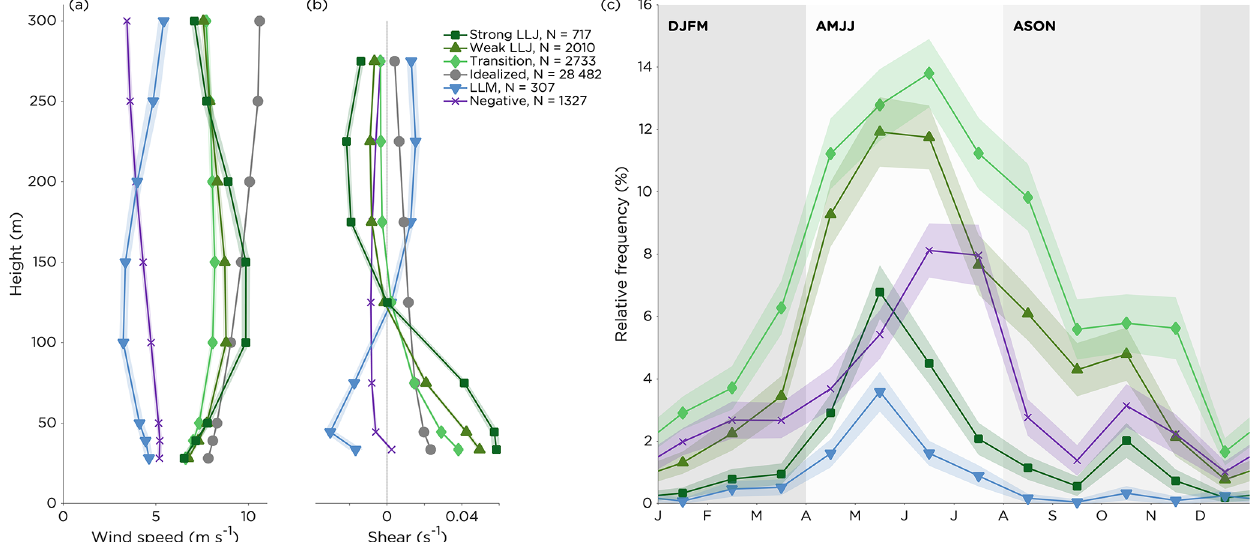
Figure 4. (a) Average vertical profiles of the wind speed and (b) wind shear for the different types of wind profiles. The total number of occurrences of the profiles is also given. In (c) the monthly average occurrence of the non-idealized profiles relative to all wind profiles is shown. The shaded areas around the profiles and in the relative occurrence plot indicate the 95% confidence interval of the mean.